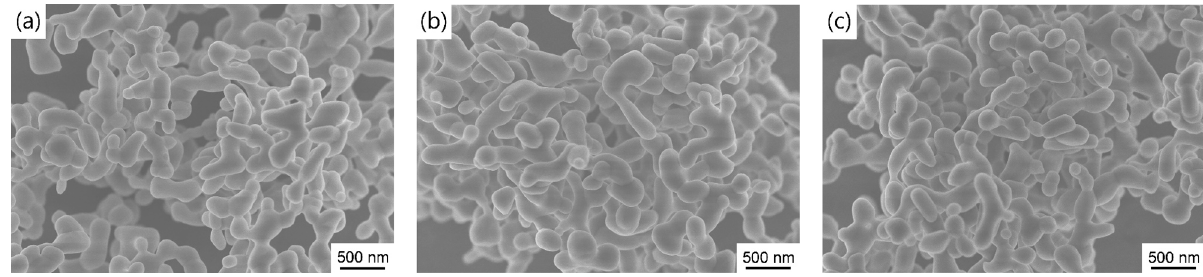
Fig. 2 FESEM images of the 1.0 at% RE:TGG powders calcined at 1150 ℃ for 4 h: (a) Pr:TGG, (b) Tm:TGG, and (c)